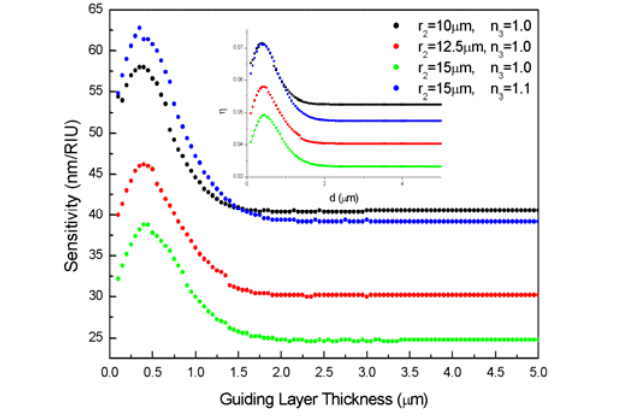
Figure 4. Sensitivity versus surface guiding layer thickness d = r sensor configurations of r energy outside the ring resonator.